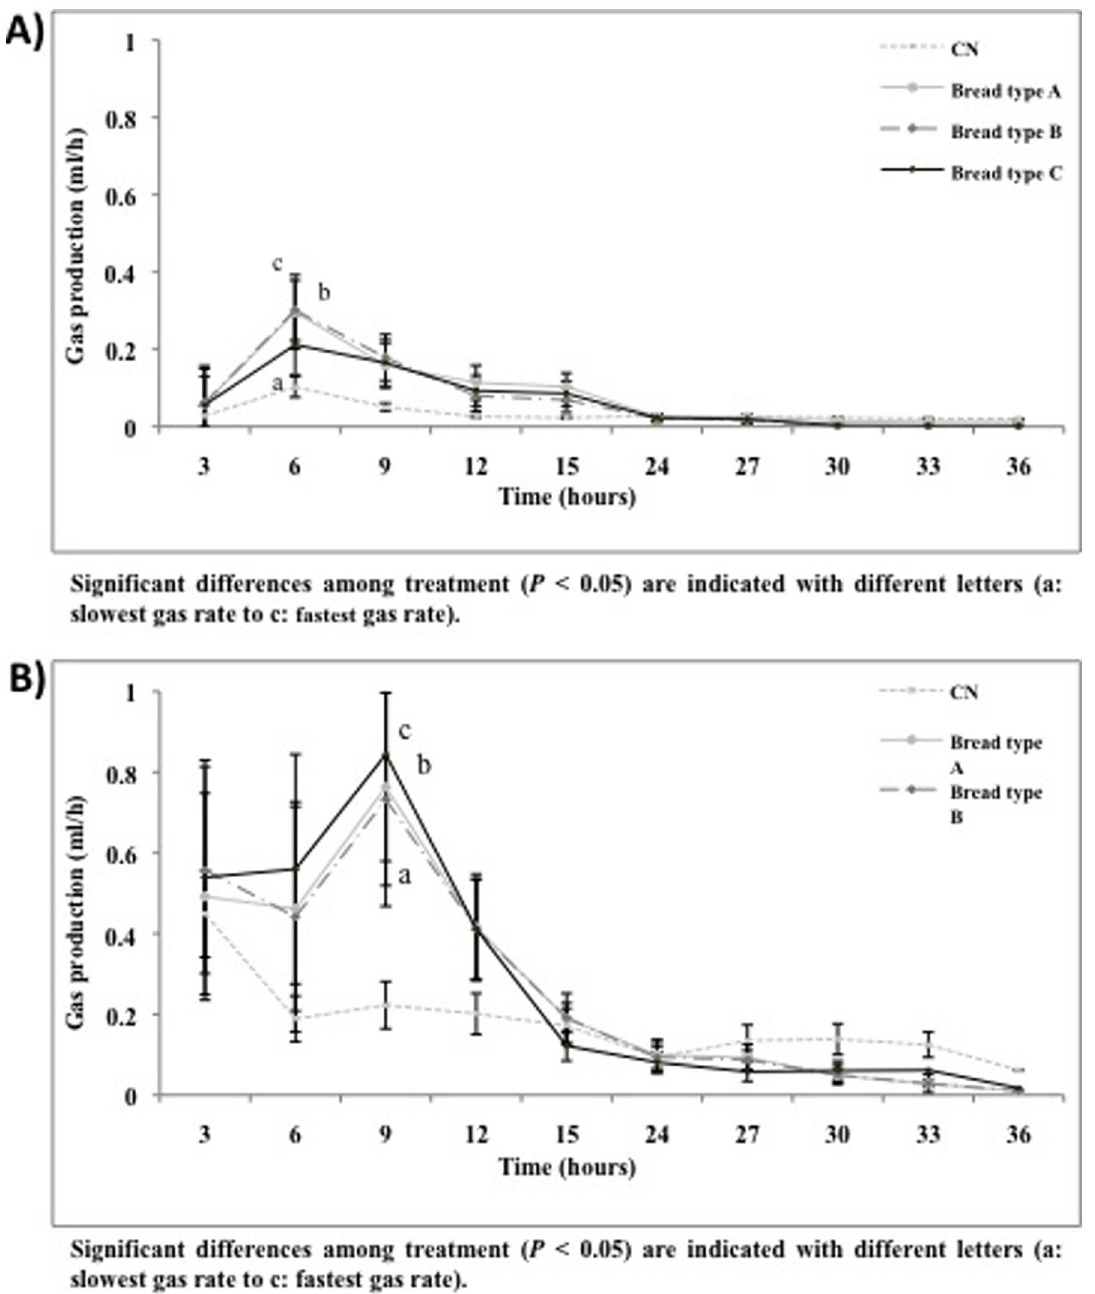
Figure 3. Gas production pattern expressed in mL per hour from non-pH controlled batch culture (average results ± standard deviation of 3 volunteers, n =3) inoculated with healthy faecal microbiota (A); Gas production pattern expressed in mL per hour from non-pH controlled batch culture (average results ± standard deviation of 3 volunteers, n =3) inoculated with IBS faecal microbiota